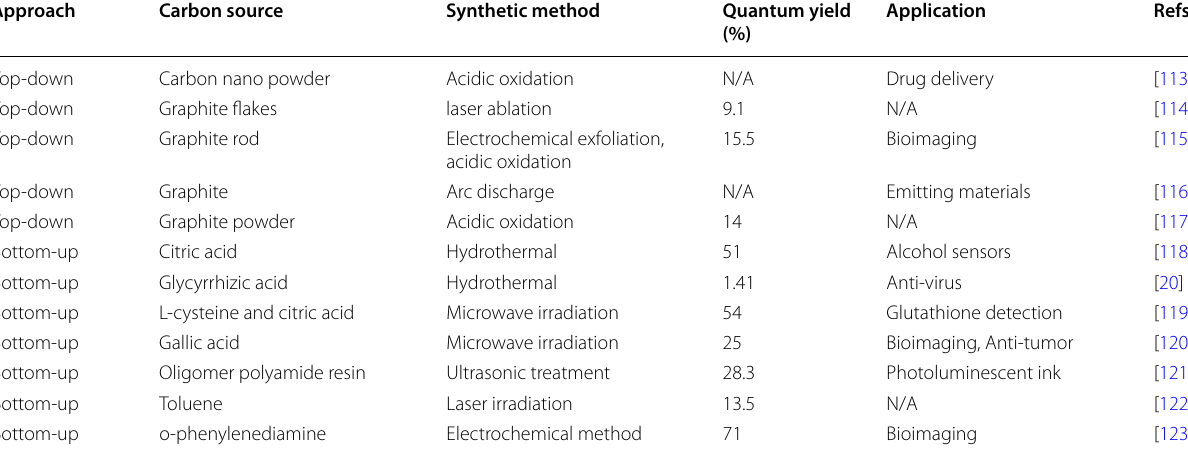
Table 4 Comparison of some recently reported synthetic